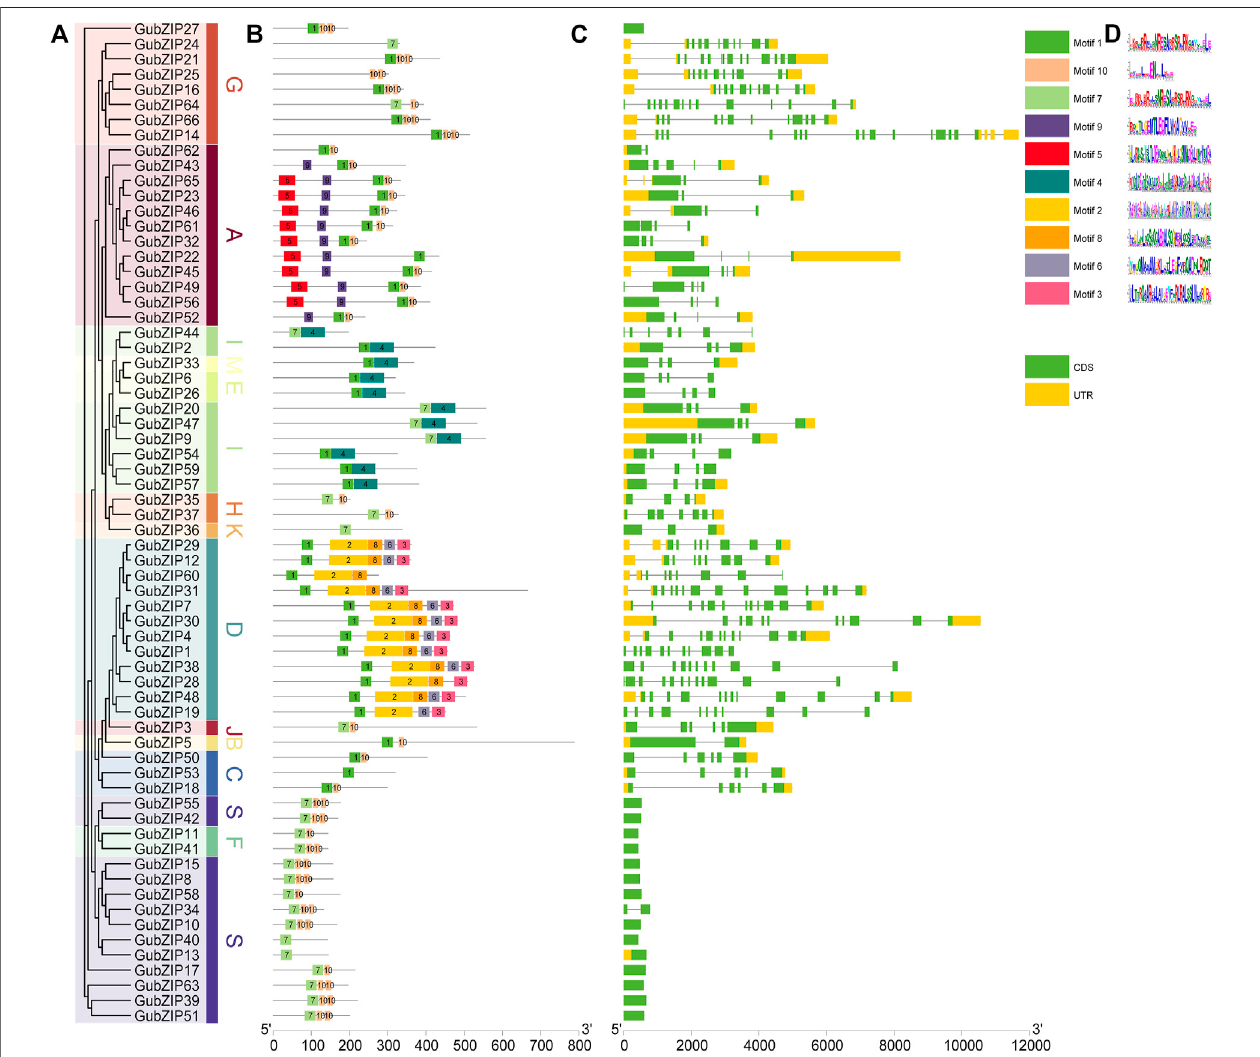
FIGURE 2 | Phylogenetic relationships, gene structure, and architecture of conserved protein motifs in GubZIPs. (A) Phylogenetic tree of GubZIP genes. (B) Distribution of conserved structures in all 66 GubZIP proteins. The colorful boxes delineate different motifs (numbers 1 – 10). Gray lines represent non-conservative sequences.Theproteinlengthcanbeestimatedusingthescaleatthebottom. (C) Theexon – intronstructureof GubZIP genes.Theyellowandgreenboxesrepresentthe untranslated region (UTR) and the coding sequence (CDS), respectively. The gray line indicates the intron. (D) Protein motifs in the bZIP members. The colorful boxes delineate different